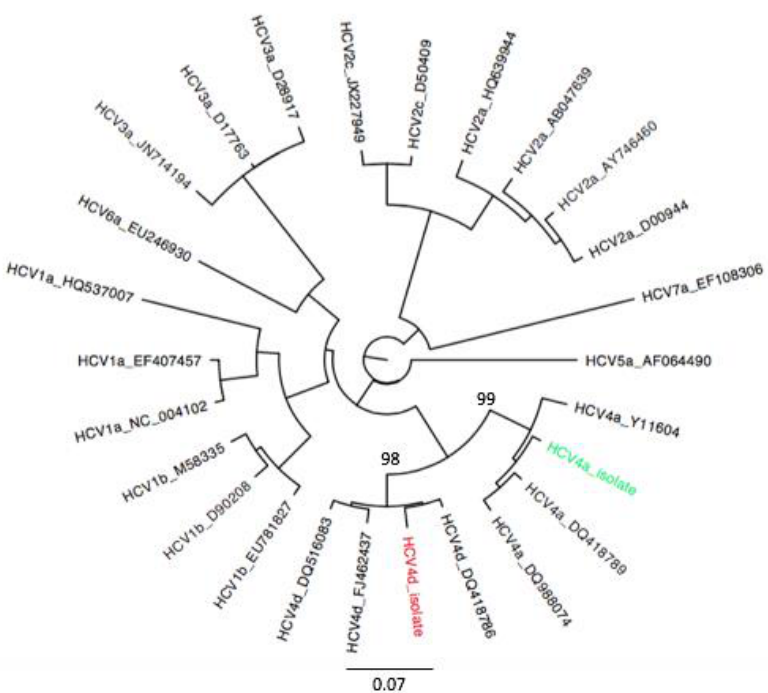
Figure 1. PhyML phylogenetic trees was estimated using 24 Hepatitis C virus (HCV) reference sequences (black), HCV4d (red) and HCV4a (green) sequences isolated in this study. The cluster reliability was supported by bootstrapping with 100 replications. Bootstrap support values are shown for the HCV4d / 4a clades. The scale bars at the bottom of the figure represent genetic distance. Table 1. Patient characteristics at baseline and along the